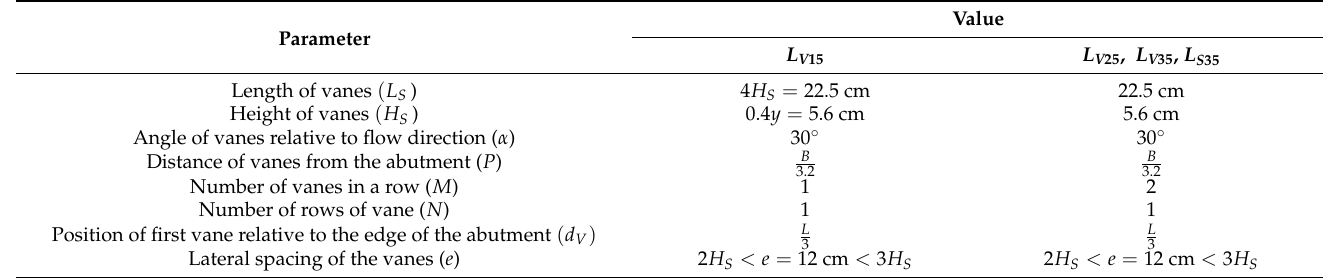
Table 2. Parameters of geometrical layout of vanes.